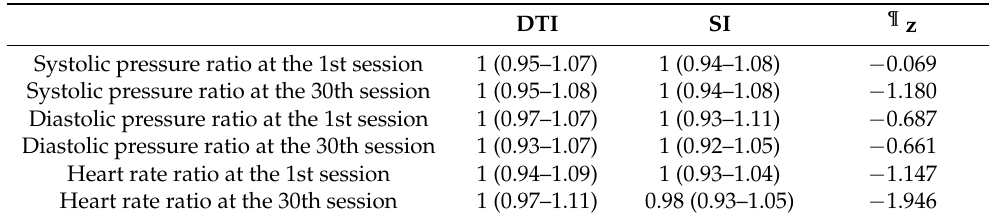
Table 3. Comparison between the experimental and control groups on systolic and diastolic pressure ratio, and hearth rate ratio # .